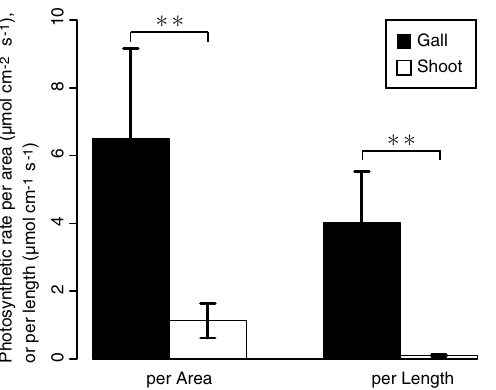
Figure 6. Photosynthetic rates in the gall and shoot. The values are shown as means ± SD. Asterisk indicates statistically significant difference (**P < 0.01; Welch’s t test).